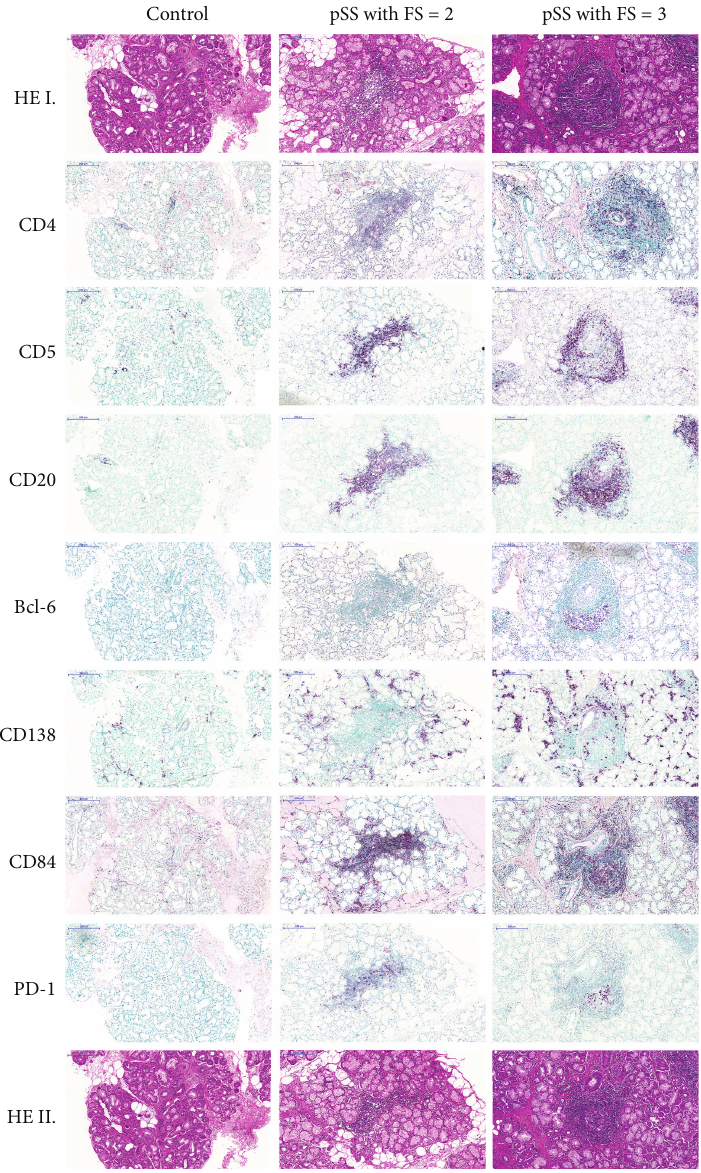
Figure 2: Immunohistochemical analysis of the division of T, B, and plasma cell markers with a special emphasis on T FH -related molecules in pSS with FS = 2 and pSS with FS = 3. Serial immunostainings of grade 2 and grade 4 aggregates show CD4 + T helper cells, CD5 + T and B1 cells, CD20 + B cells, and CD138 + plasma cells and markers which play a role in the T FH -B cell interaction, namely, CD84, PD-1, and Bcl-6. The magnification of digitalized slides is 10x. Scale bar 200 𝜇